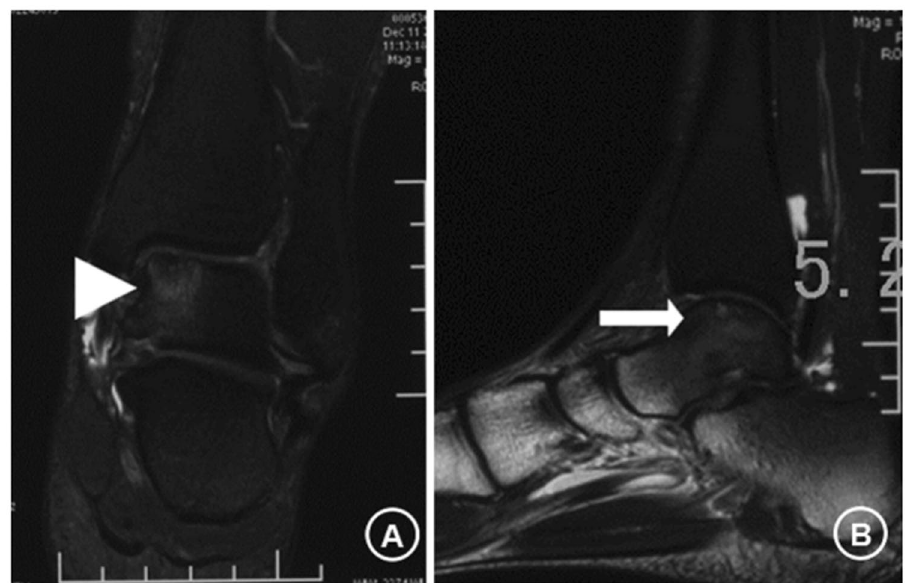
Figure 3. T2-weighted coronal ( A ) and sagittal ( B ) magnetic resonance images of the ankle. Images at 6 months post-retrograde autologous bone marrow cell transplantation via core drilling combined with focused extracorporeal shock wave treatment. Clear evidence of mild marrow edema and repair of osteochondral lesions ( A , arrow head; B , arrow). Note: The patient consented to publish the specific